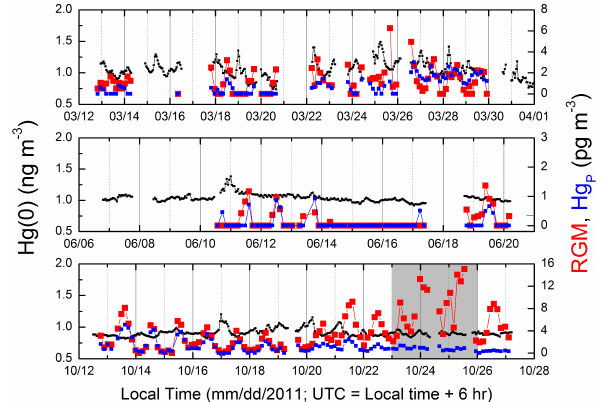
Fig. 3. Atmospheric Hg(0), reactive gaseous mercury (RGM) and particulate mercury (Hg P ) in the MBL on the Galápagos Islands during three different periods in 2011. The data for March and June were obtained from Puerto Villamil on Isabela Island, and those for October were from Puerto Baquerizo Moreno on San Cristóbal Island. The temporal resolution was 5min for Hg(0) (1h averages are shown here) and 3hr for RGM and Hg P . Shaded in grey is the period (23–25 October) when an unusual diurnal change in RGM was observed, which was most likely due to a localized and short- lived